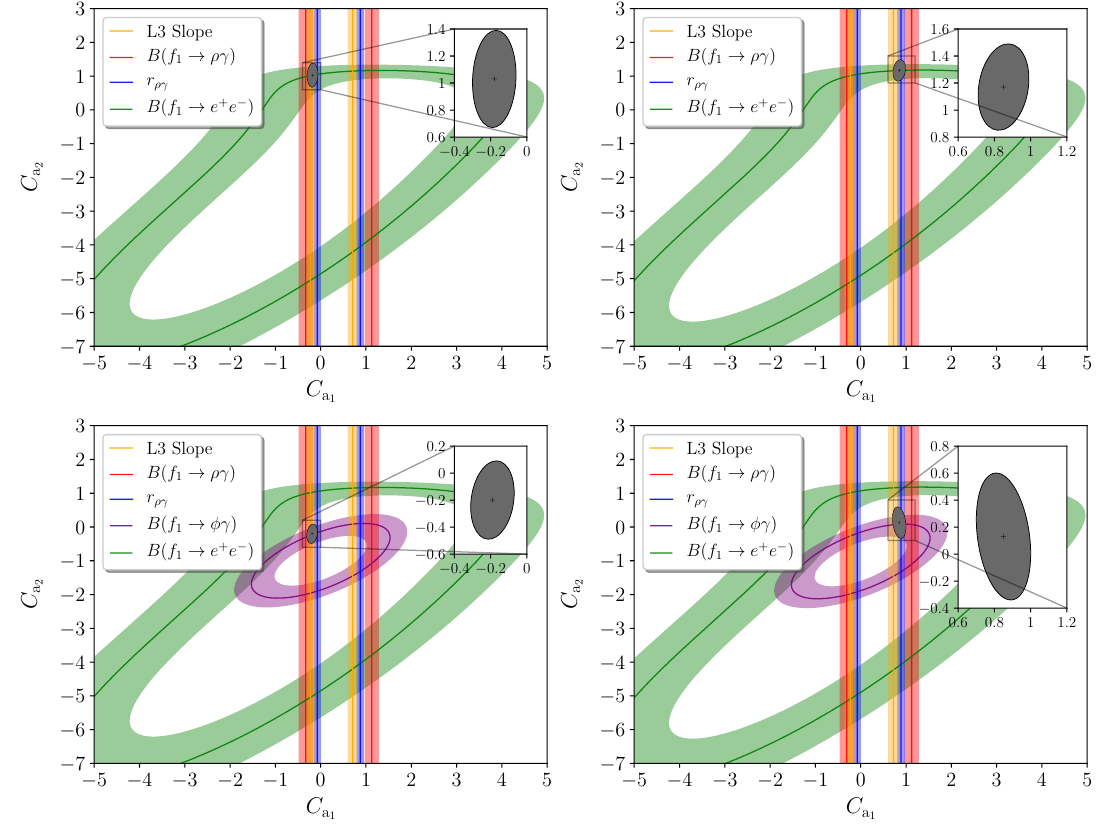
Figure 12 . Contours in the C a – C a plane for the best-fit value of C s in the extended VMD 1 2 representation: for Solution 1 ( left ) and Solution 2 ( right ), without ( upper ) and including ( lower ) the constraint from B ( f 1 → φγ ) . The best-fit region is indicated by the ∆ χ 2 = 1 ellipse (inflated by the scale factor). We do not consider equivalent solutions with very large negative C a without the B ( f 1 → φγ ) constraint. Further local minima when including B ( f 1 → φγ ) mirror the indicated Solutions 1 and 2 on the lower branch of the ellipse, but display a worse χ 2 / dof and are thus